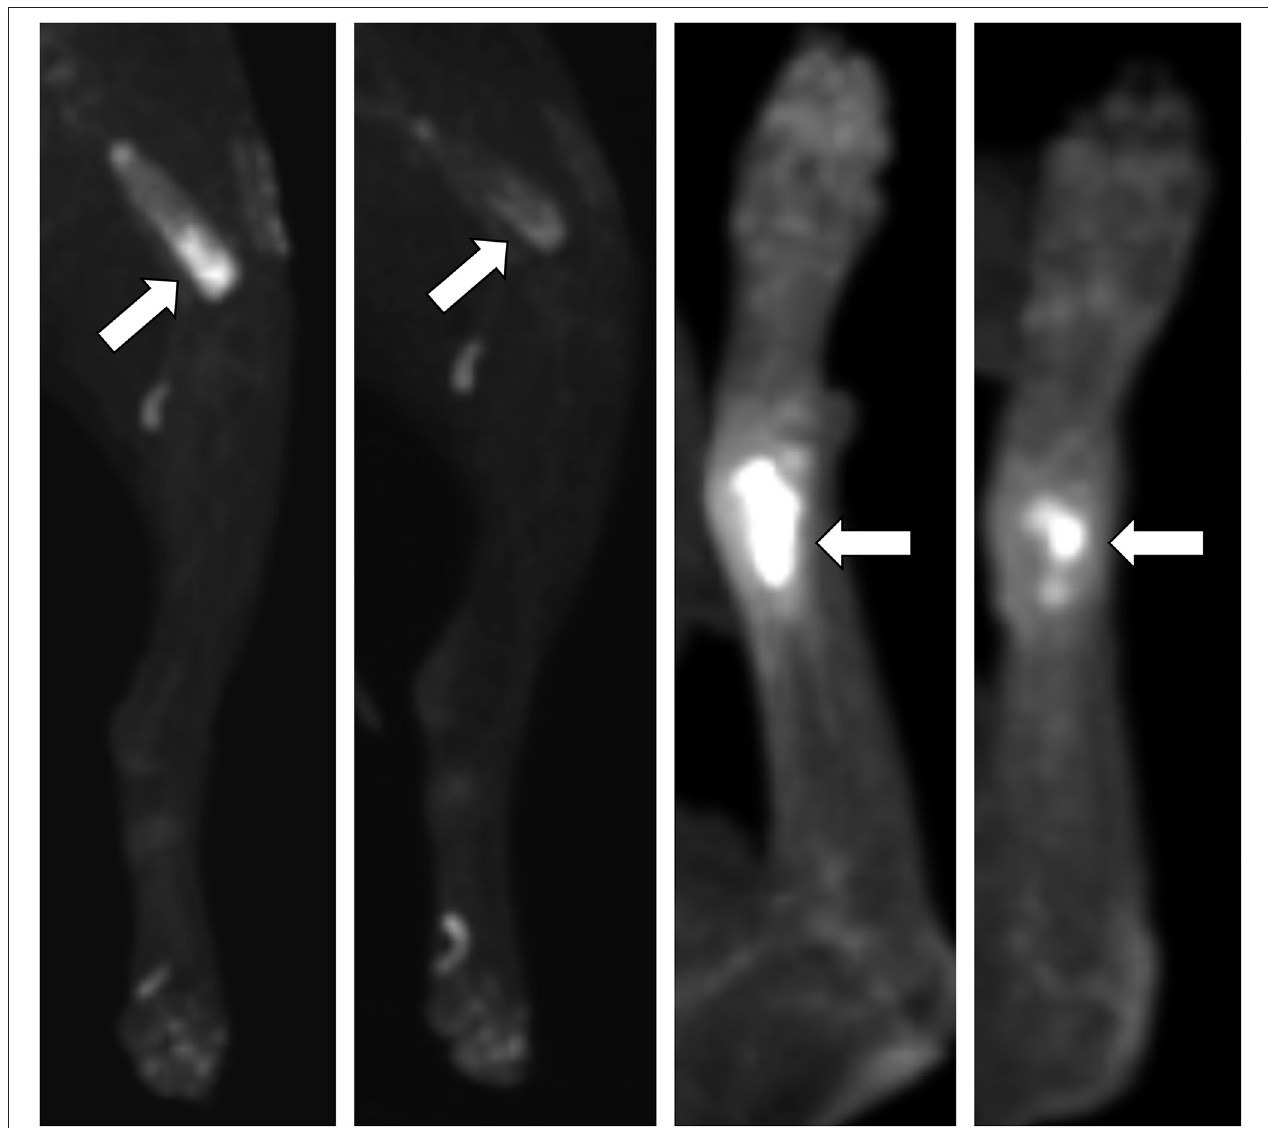
FIGURE 6 | Baseline and day 28 2D images of 18F-FDG PET scans in two dogs with appendicular primary bone tumors receiving ZOL + RT. Both dogs had reductions in standard uptake value (SUV max ) and tumor count intensity, with no change in gross tumor volume (GTV), and increases in tumor count uniformity. Dog #5 (two left panels) had a distal femur lesion; dog #7 (two right panels) had a distal radius lesion. Primary bone tumors with high intensity 18F-FDG uptake are noted by white arrows, with visual increase in tumor uniformity and decrease in intensity noted on 28-day scans.